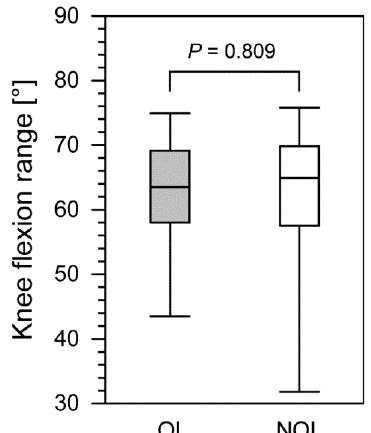
Figure 3. The comparison of knee flexion range between the operated and non-operated limbs in patients after treatment with the Ilizarov method. The lower border of each box indicates the 25th percentile, the line within the box marks the median, and the upper border of each box indicates the 75th percentile. The whiskers above and below the boxes indicate the 90th and 10th percentile, respectively. Filled box, operated limb (OL); white box, non-operated limb